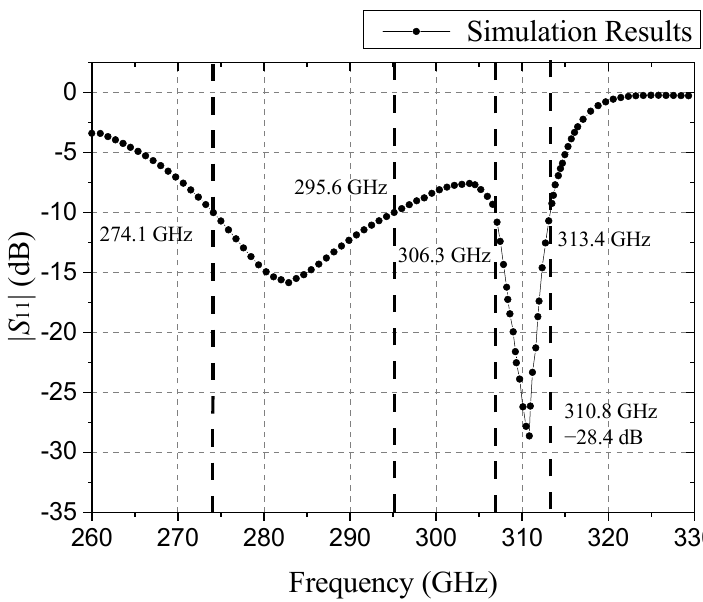
Figure 11. | S 11 | of simulation results.